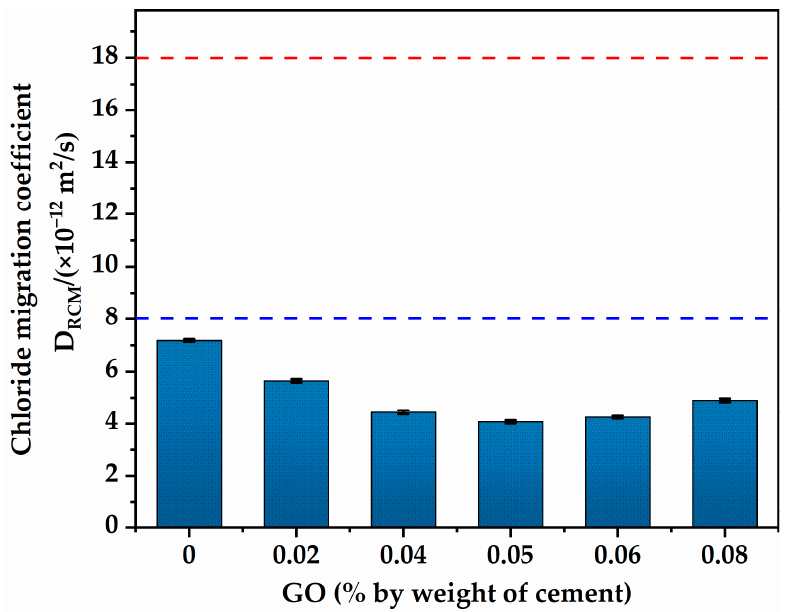
Figure 10. The chloride-ion migration coe ffi cient of HSLWC with di ff erent contents of GO.